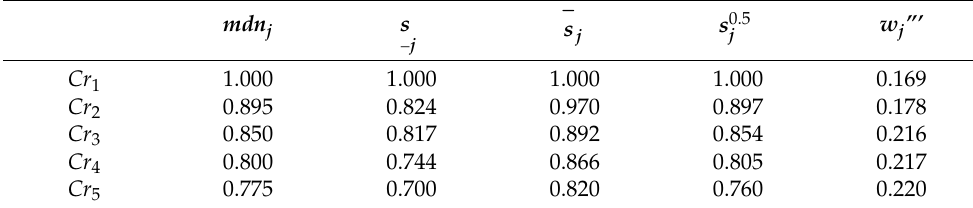
Table 16. The criteria weight obtained based on grey ratings.